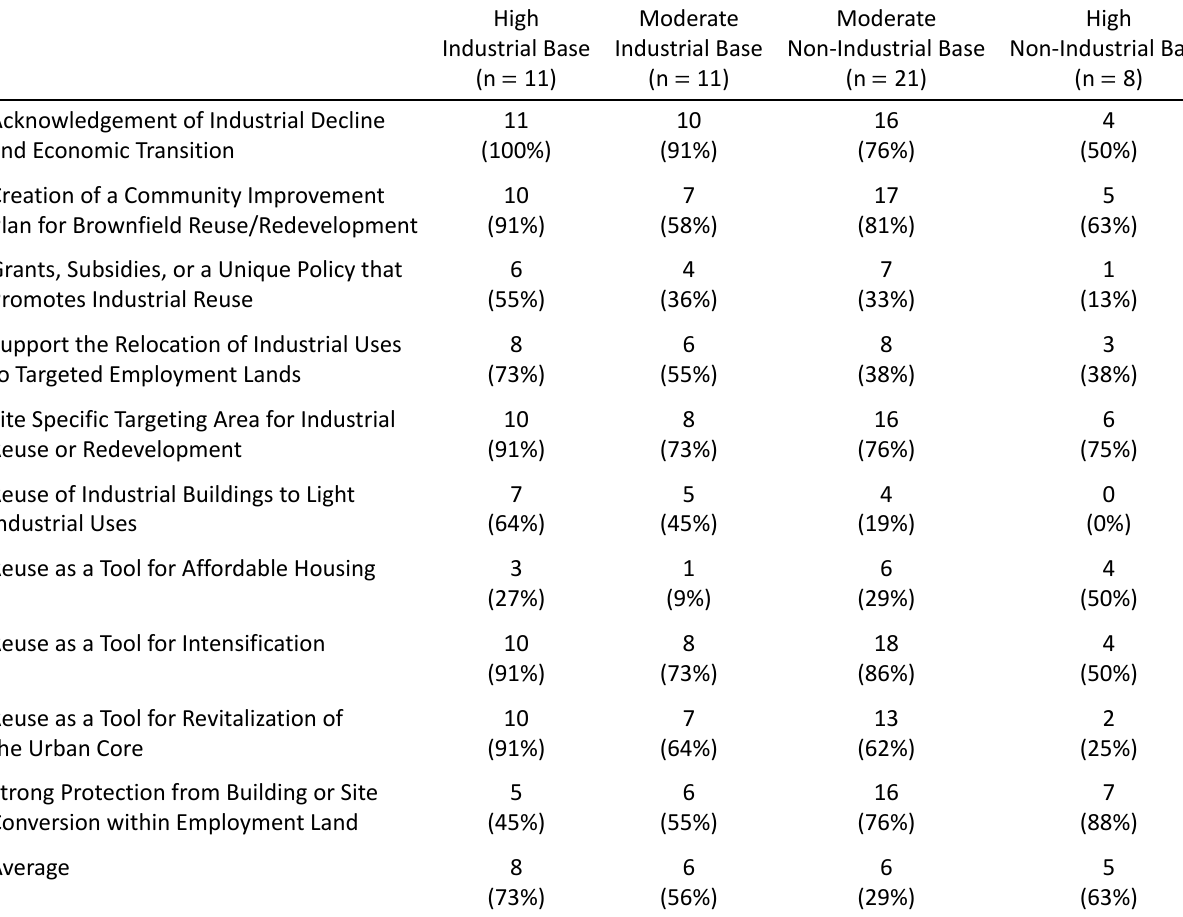
Table 4. Thematic descriptions by economic